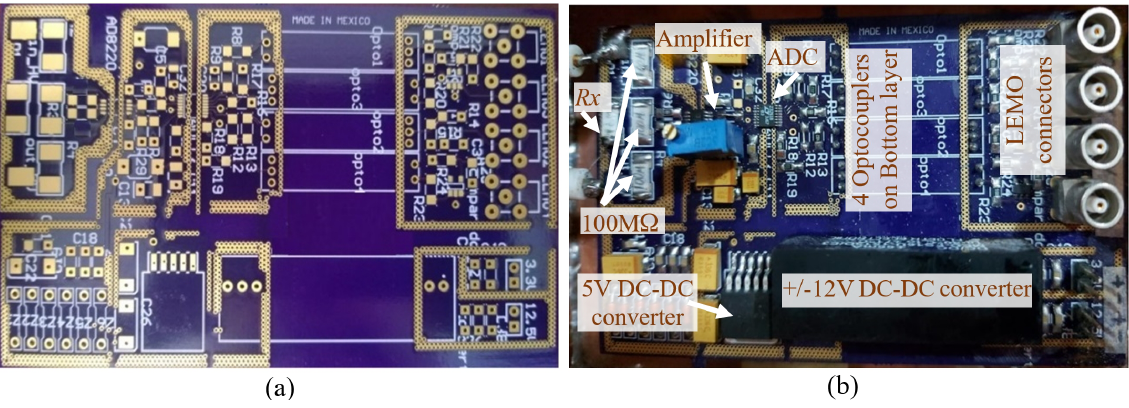
Figure 4. Photo of the PCB. ( a ) PCB without components and ( b ) PCB with components